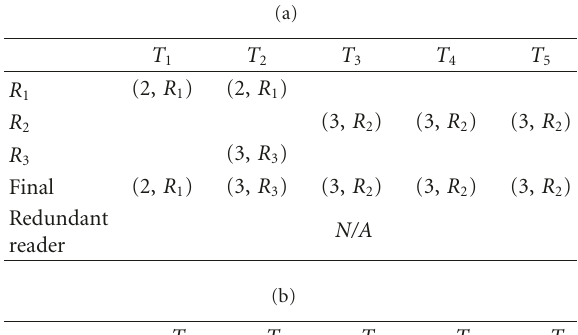
Table 1: Redundant reader identification for the second example: (a) result of RRE, (b) result of LEO .